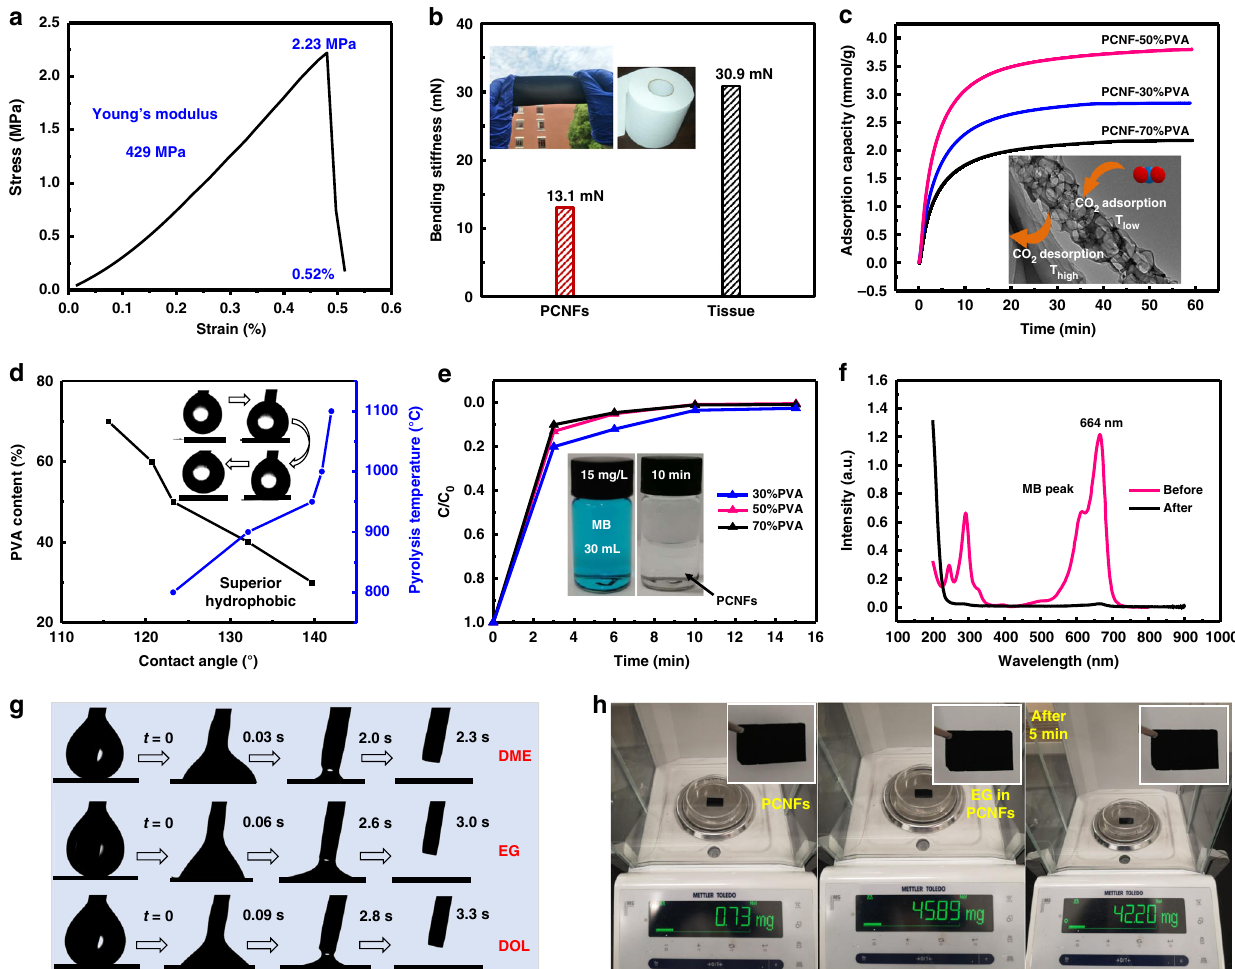
Fig. 3 Practical applications of the PCNF fi lms. a Tensile stress – strain curve of the PCNF – 50% PVA fi lm that fabricated at 1200 °C. b Comparison of the bending rigidity between the PCNF fi lm and the tissue. c – e The CO 2 adsorption performance, super hydrophobic properties, and dye-absorption properties of the PCNFs. f Characterization of ultraviolet spectrum of using the PCNFs to absorb the MB dye. g The organic solvent wettability and h liquid storage performance of the PCNFs. Source data are provided as a Source Data fi